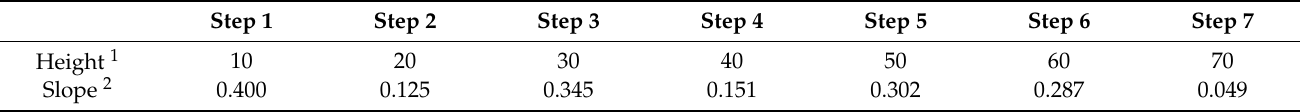
Table 1. Calibration slopes for the equivalenet power of 20%.